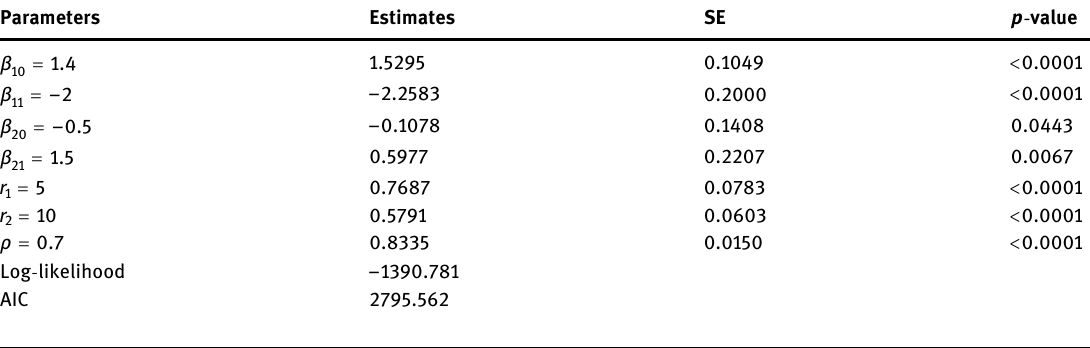
Table 1: Parameter estimates, standard errors, p - values, and the AIC value of the fi tted model M 1 using 500 data points Parameters